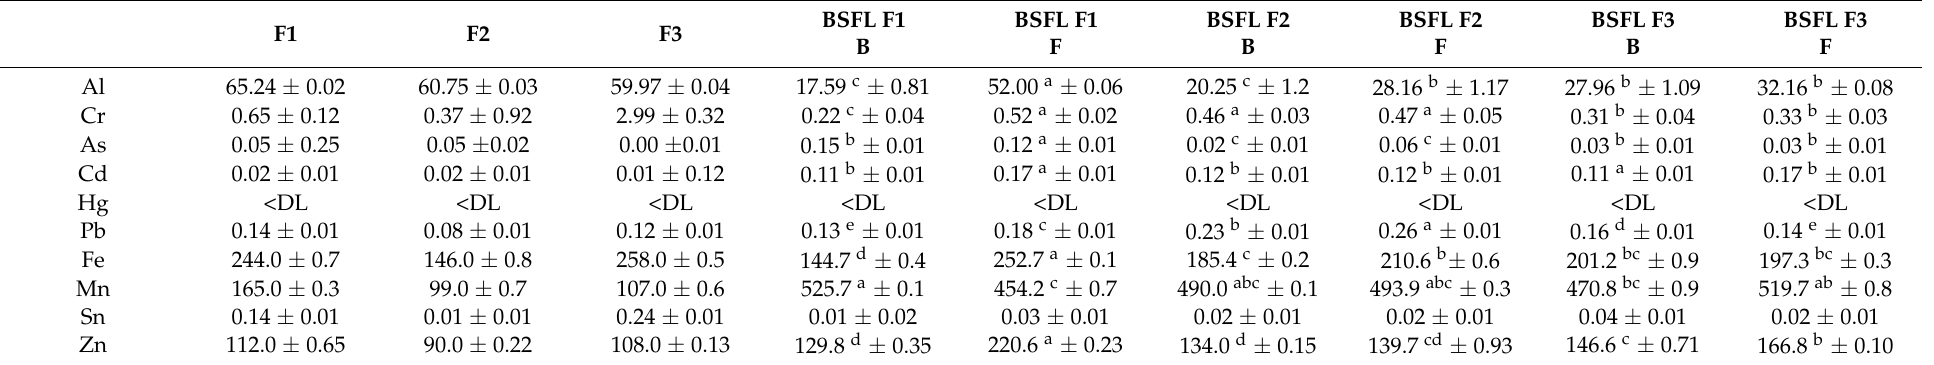
Table 4. Heavy metal content (mg/kg dry matter basis) of black soldier fly larvae grown on three different feeds and killed by blanching and freezing (means and